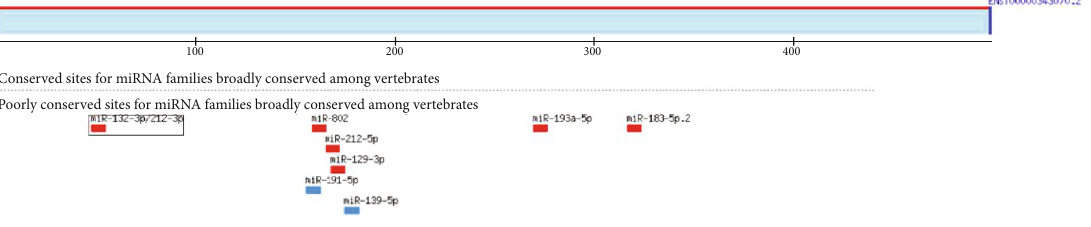
Figure 6: (a) The miRNA-binding of ATP1A2. (b) The miRNA-binding of KCNMA1. (c) The miRNA-binding of PLN. (d) The miRNA- binding of